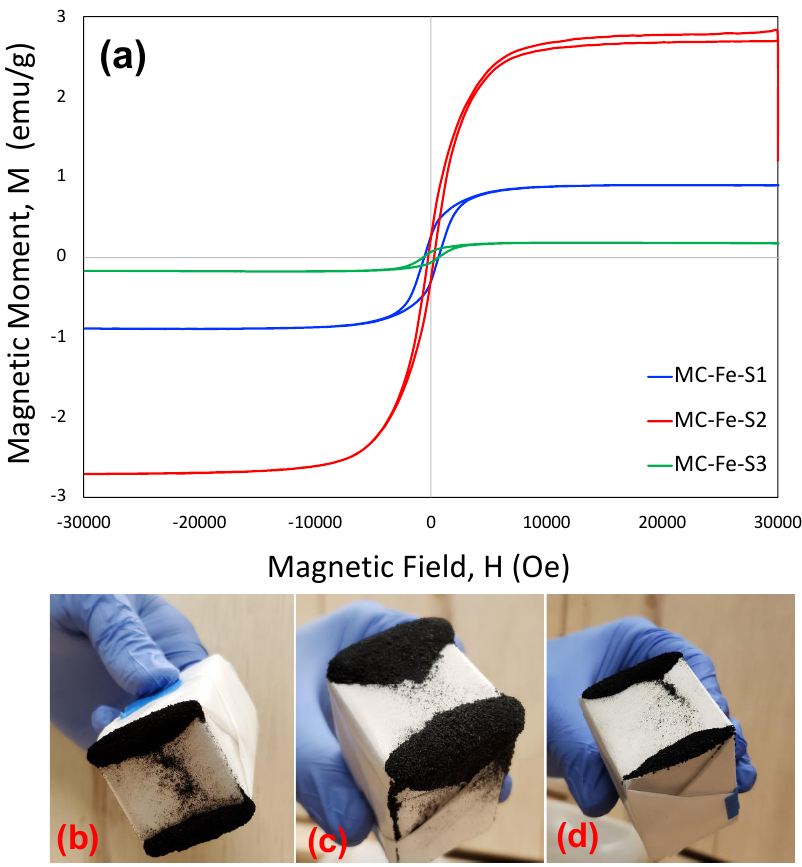
Figure 5. Demonstration of magnetic properties of iron and sulfur dual-doped mesoporous carbons by magnetization experiment ( a ), physical attractions of mesoporous carbons with neodymium magnet for MC-Fe-S1, ( b ) MC-Fe-S2, and ( c ) MC-Fe-S3 ( d ).